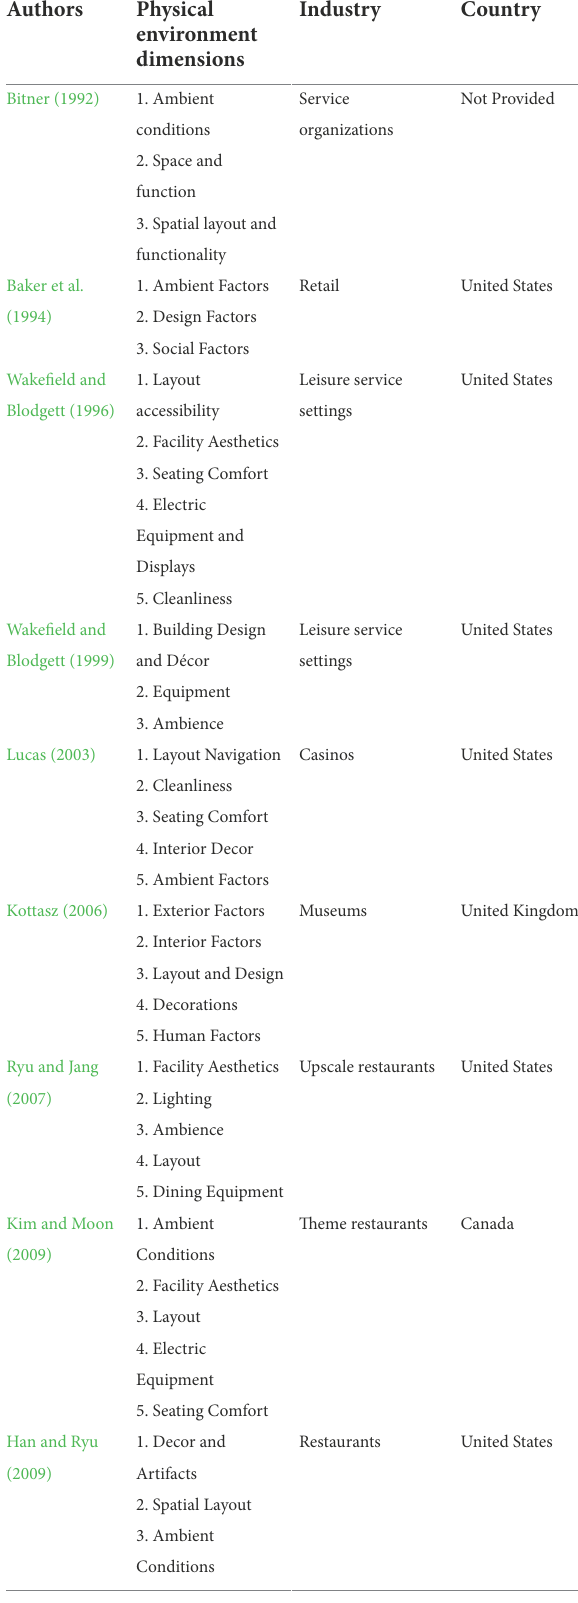
TABLE 1 Physical environment